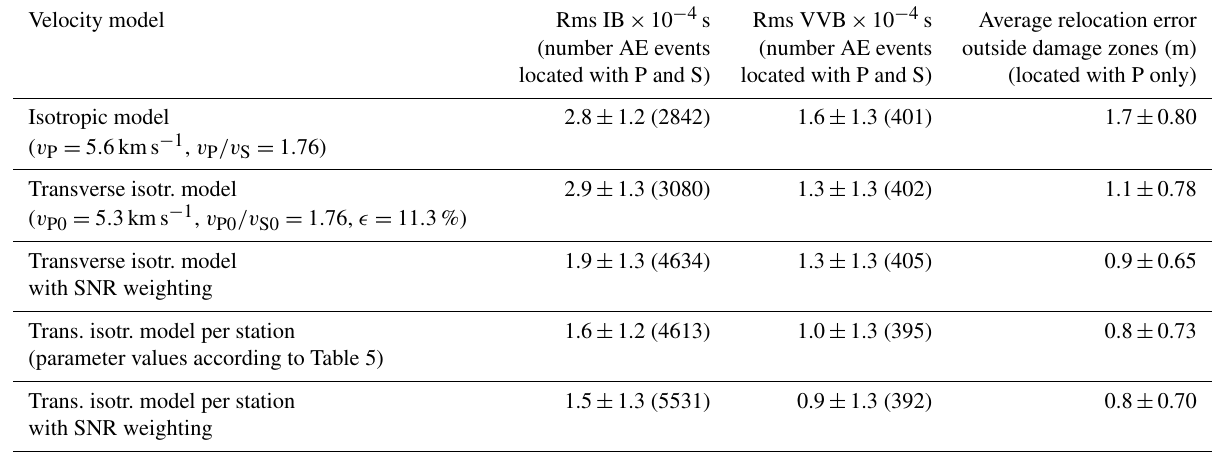
Table 6. Comparison of root-mean-square residual and number of obtained event locations in the injection (IB) and vertical validation borehole (VVB) obtained using different velocity models. For location accuracy assessment, the average relocation error of the known UT measurement points outside of identified damage zones is provided, which represents an average of all values shown in Fig. 4b. Velocity model outside damage zones (m) located with P and S) located with P and S) (located with P only) Isotropic